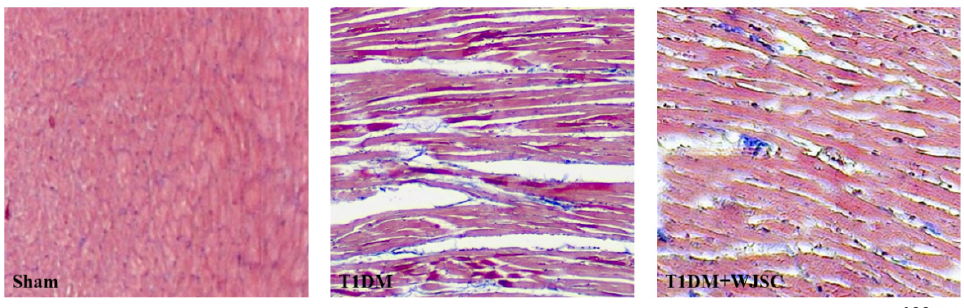
Figure 1. HE stain for heart tissues.